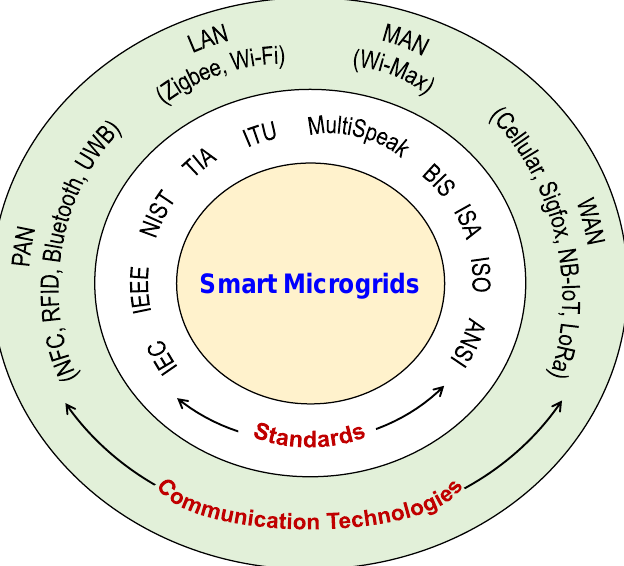
Figure 4. Key standards and technologies for smart microgrid communication.